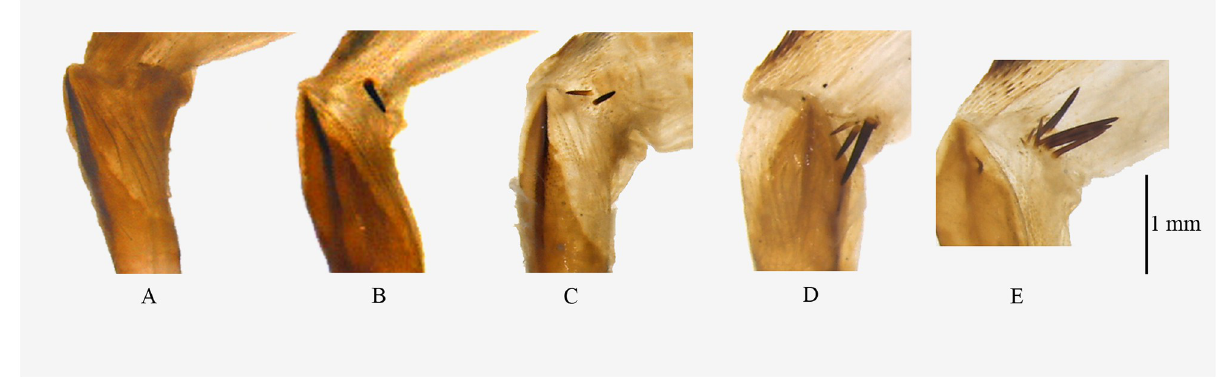
Fig 14. Variation of Basal spine of vesica in aedeagus in Psyra crypta . A. Absence of spine B. A single spine C. Double spine D. Triple spine E. Multiple spine.